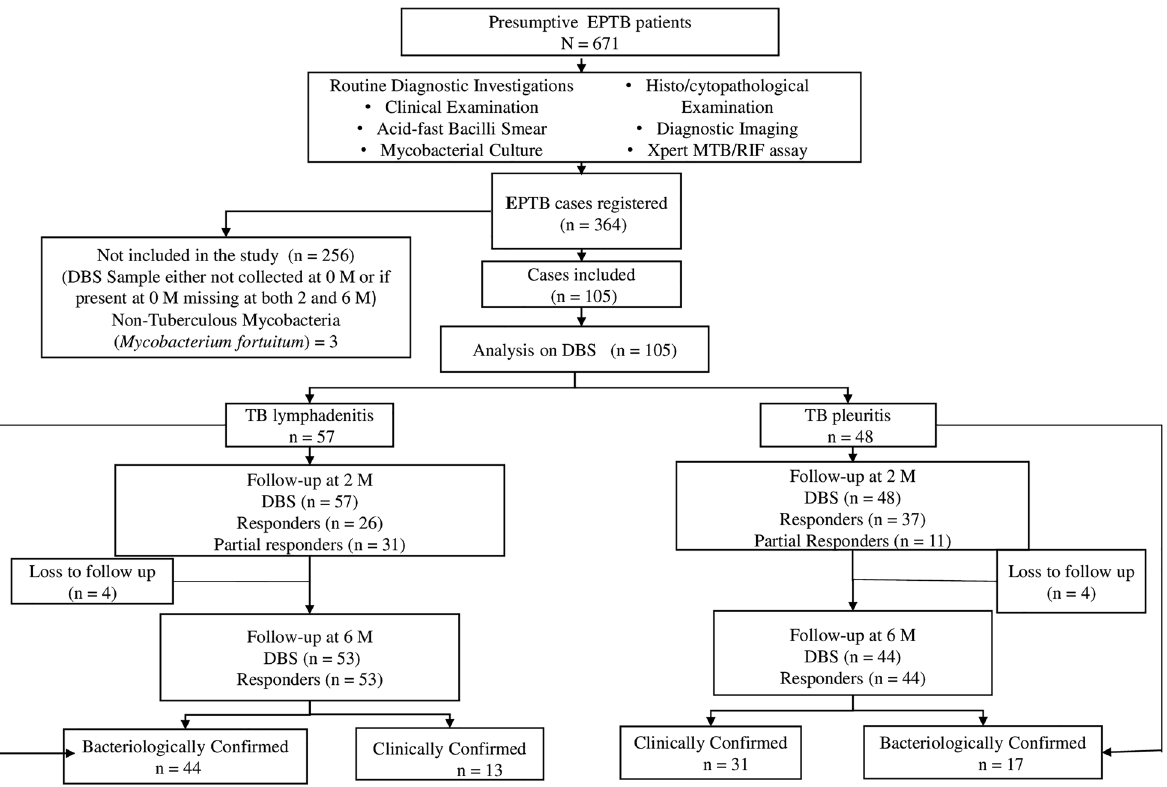
Figure 1. A flow chart showing the study design and the timeline of DBS collection during the study. DBS dried blood spots, EPTB extrapulmonary tuberculosis, M month of the treatment, N total number, n number in